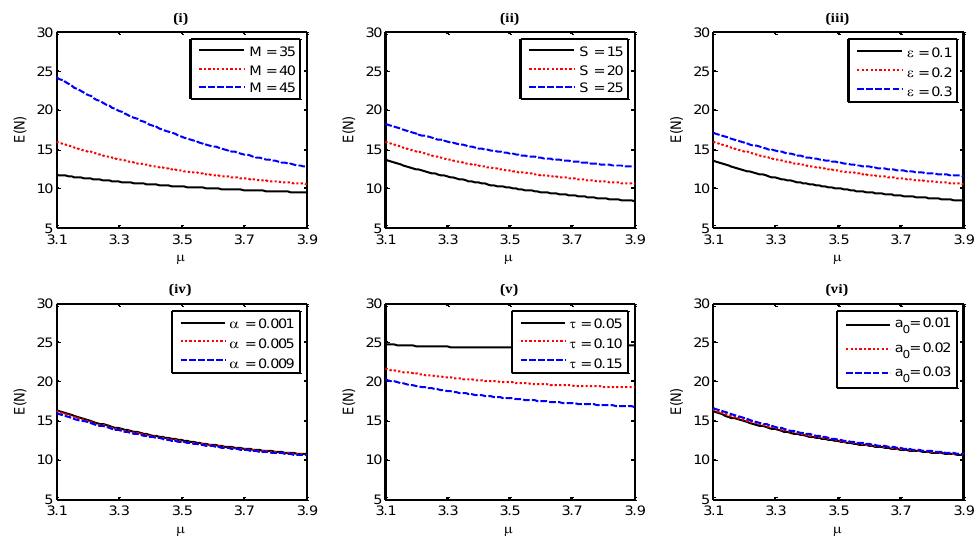
Figure 3. The expected number of failed machines in the system ( ) NE wrt service rate of the failed machines ( )  .